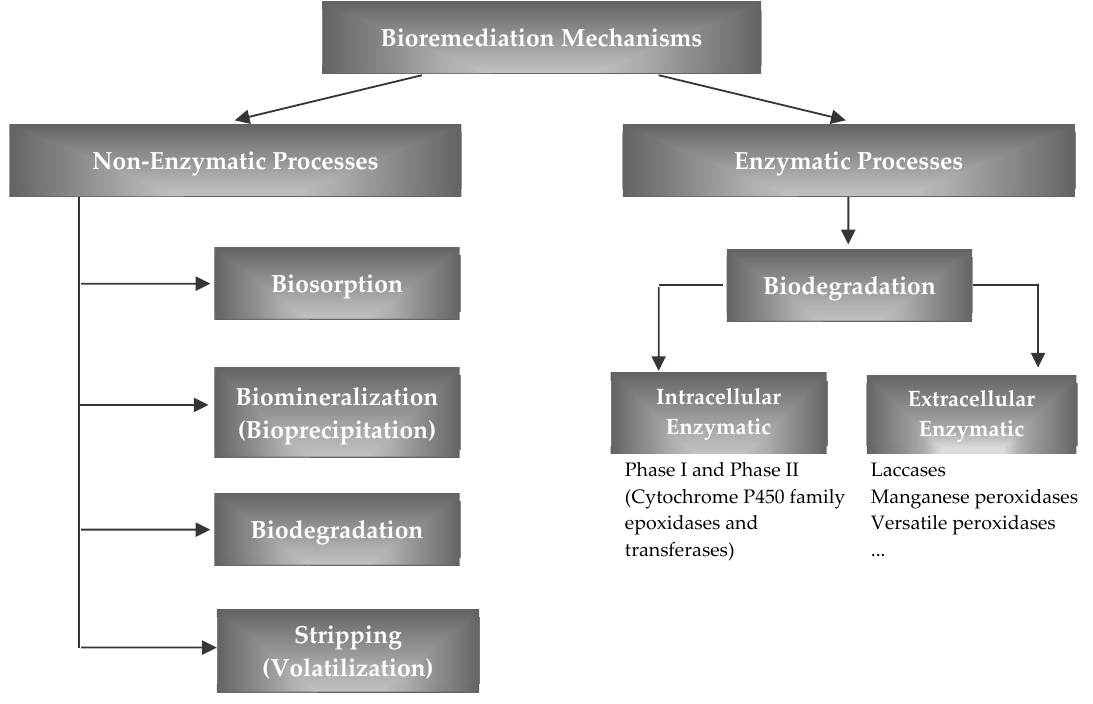
Figure 3. Fungi and algae strategies to counteract pharmaceuticals.